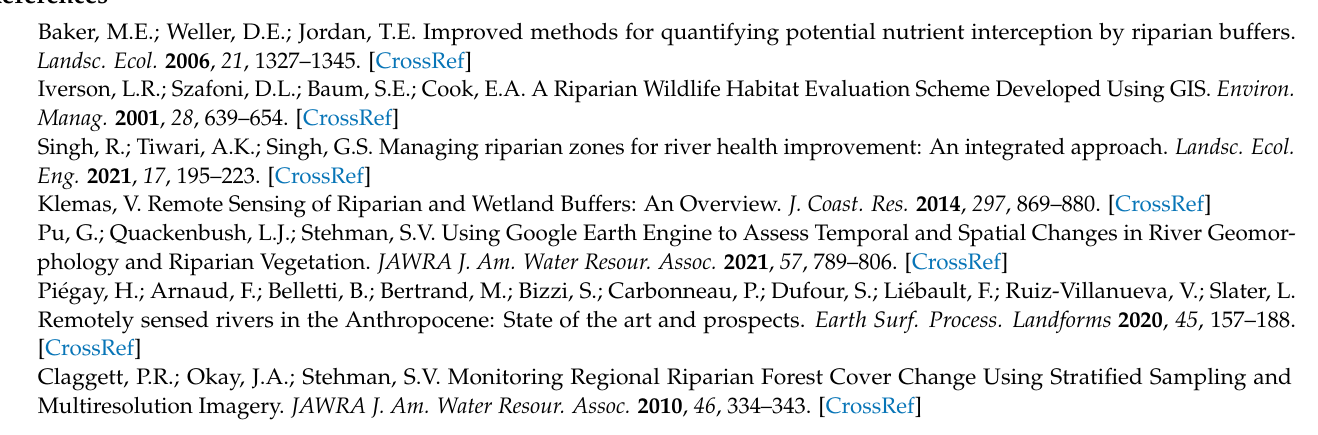
figshare at https://doi.org/10.6084/m9.figshare.15086640, Last accessed 16 November